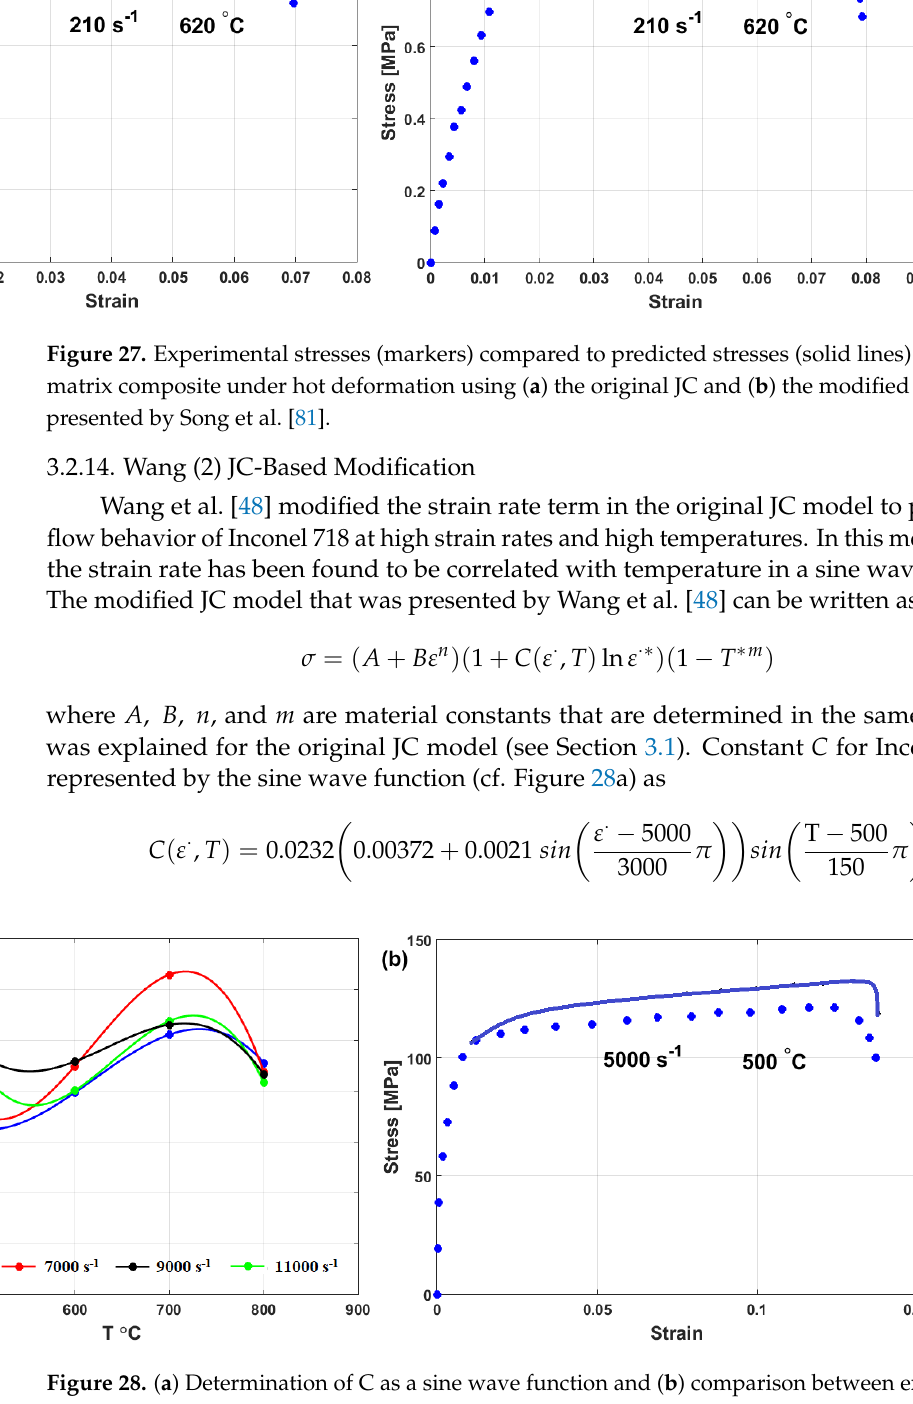
Figure 26. Determination of constants 𝜆 1 and 𝜆 2 at ( a ) 210 s −1 and ( b ) 1252 s −1 .